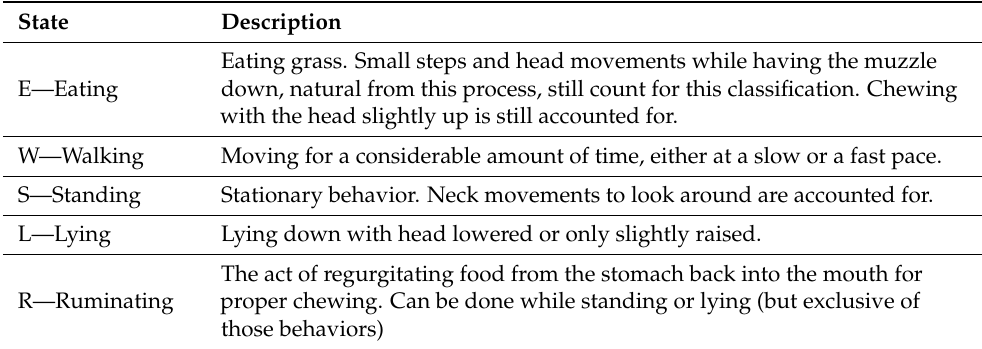
Table 1. Ethogram of captured